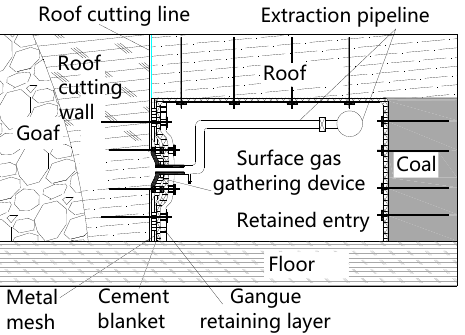
Figure 32. Schematic diagram of the cement blanket closure and areal gas-gathering device pro- gram.